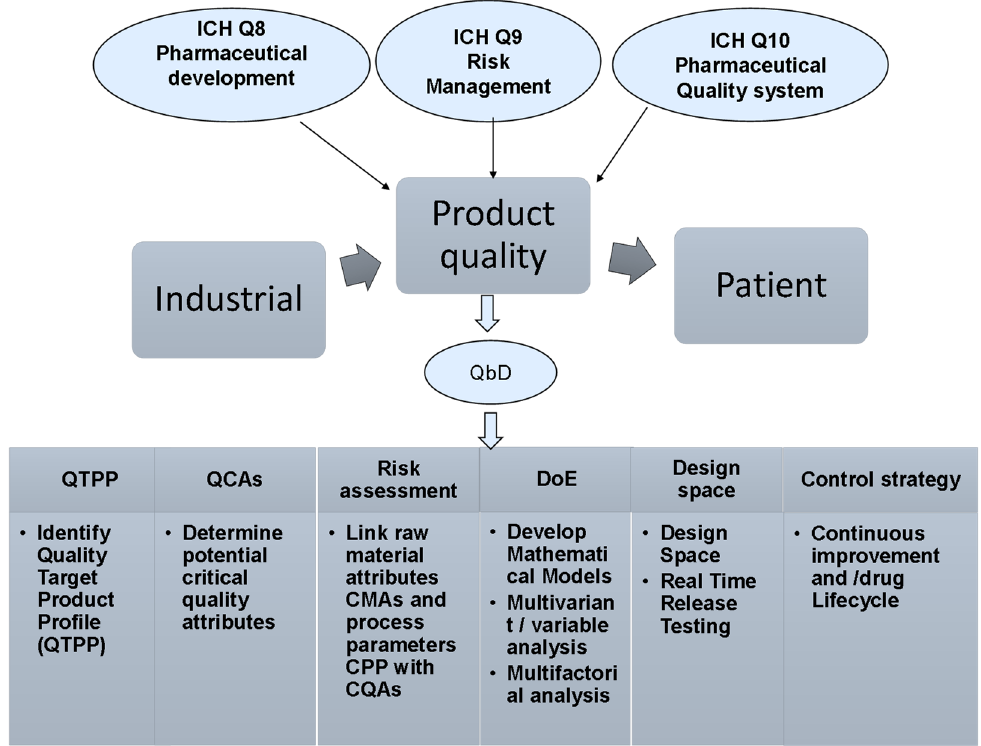
Figure 1. The pharmaceutical development guidelines suggested by ICH, US FDA and EMA to outline the QbD key elements to ensure the consistency of high-quality pharmaceutical products.